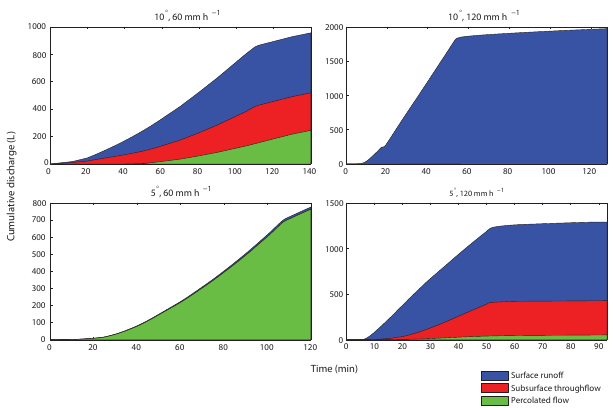
Figure 2. Plots showing cumulative discharge from surface runoff, subsurface throughflow and vertical percolated flow from the slurry- treated slope experiments.